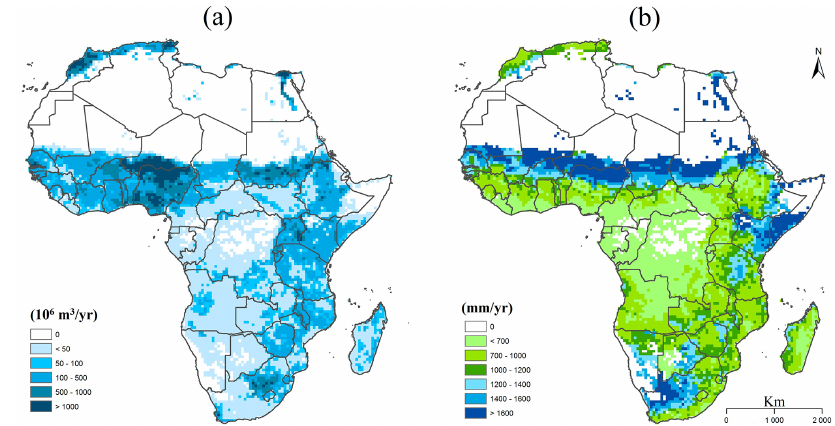
Figure 4. Estimated average net irrigation water demand (1960–2000) for the cropland in Fig. 1: (a) expressed in 10 6 m 3 year − 1 cell − 1 (0.5 ◦ × 0.5 ◦ ) and (b) in mmyear − 1